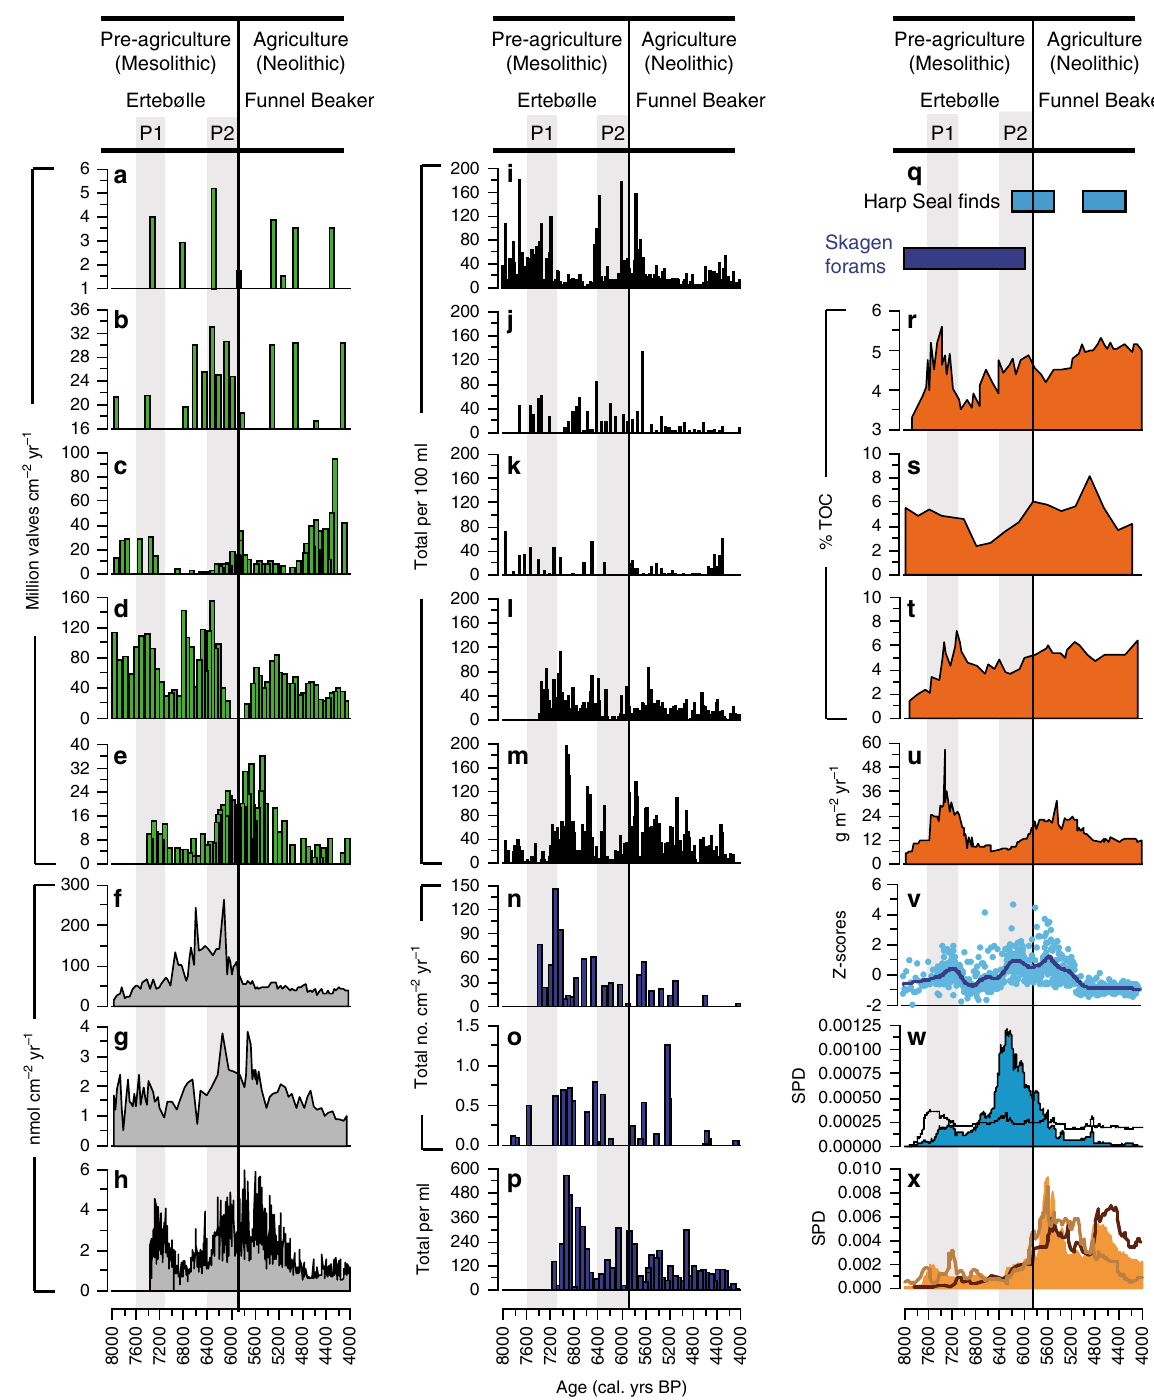
Fig. 3 Marine productivity indicators across Southern Scandinavia and the Baltic Sea from 8000 – 4000 BP. P1 and P2 refer to periods of pre-agricultural marine production increase across Southern Scandinavia. a – e Diatom fl ux ( a Sebbersund, b Tempelkrog; c Norsminde Fjord; d Horsens Fjord; e Kilen). f – h Total sedimentary pigment fl ux: ( f Tempelkrog; g Horsens Fjord; h Kilen). i – m Number of molluscs per 100 ml of wet sediment ( i Tempelkrog; j Sebbersund; k Korup Sø; l Kilen; m Horsens Fjord). n – p Foraminiferal fl ux ( n Kilen; o Norsminde Fjord; p Horsens Fjord). q Faunal indicators of high productivity: appearance of 14 C dated harp seal ( Phoca groenlandica ) remains found in Denmark 41 and phase of increased fl ux of foraminifera present in the northern Kattegat 66 . r – u Organic carbon indicators of productivity from the Baltic Sea. Percentage total organic carbon (TOC) in sediment sequences from r Little Belt 67 , s Gotland Basin 68 , t Gotland Basin 69 , u TOC fl ux at Gotland Basin 70 . v – x Key summary data from this study for comparison (see text and Fig. 2 for details); v Total sedimentary pigment fl ux z-scores (with lowess smoother; span 0.1; based on the data plotted in f – h ). w Summed probability distribution (SPD) of 14 C-dates of shells of the European fl at oyster ( Ostrea edulis ) from Danish shell middens. Black line indicates expected probability distribution . x Population density proxy for southern Sweden, Jutland and the Danish islands during the mid-Holocene 7